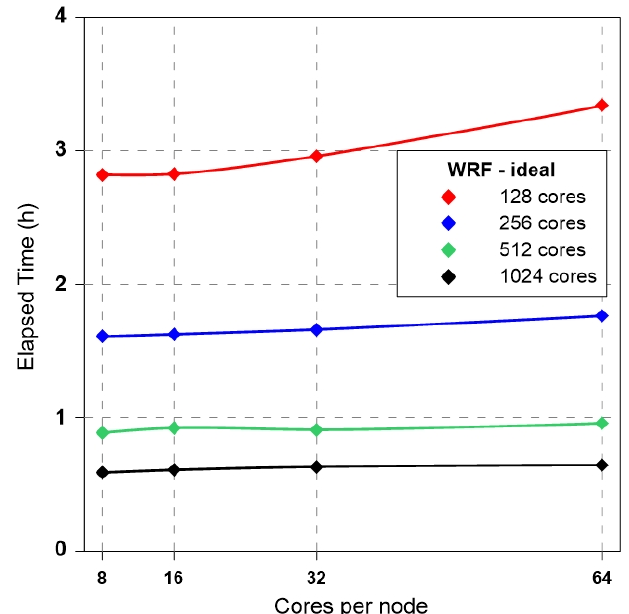
Figure 4. WRF-LES performances using 8, 16, 32 and 64 cores per node while reducing the number of nodes in the KNL system.